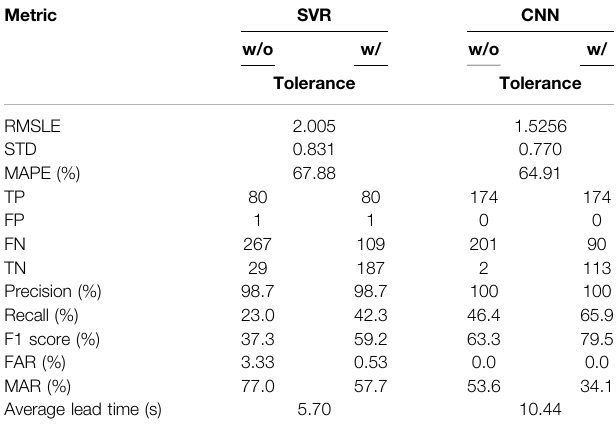
TABLE 4 | The performance metrics of the Chi-Chi earthquake data set using the SVR approach and the CNN approach. Metric